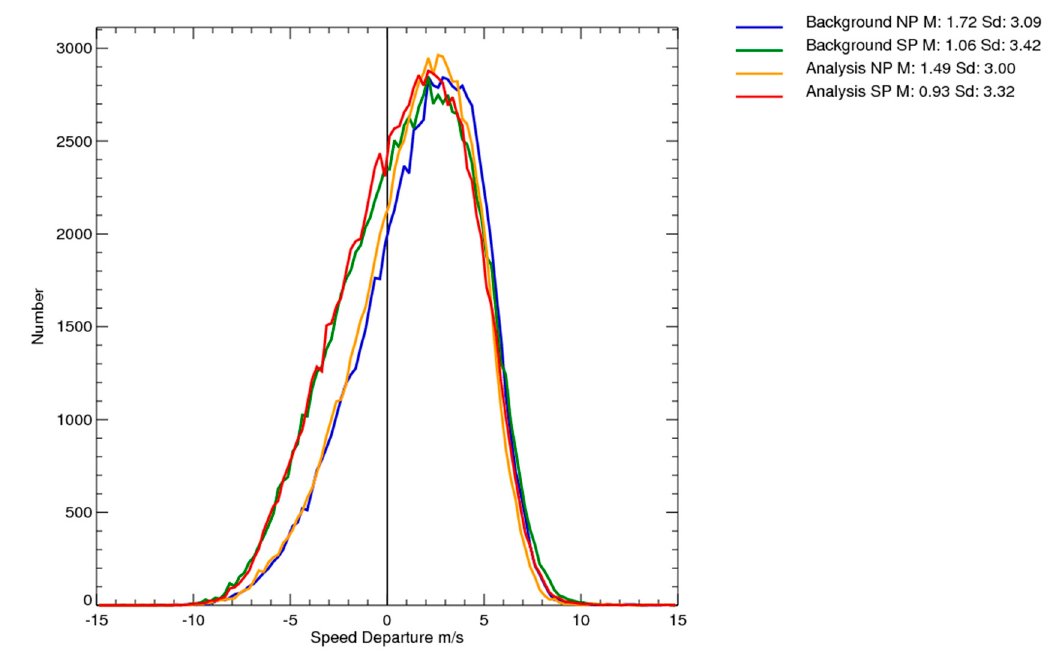
Figure 11. Distribution of speed departure for 01–29 July 2012 for the AIRS ozone AMVs. Compared to the background (Arctic–blue; Antarctic–green) and analysis (Arctic–yellow; Antarctic–red). The impact per observation (Figure 12) is very good for the AIRS moisture AMVs, as they are ranked higher than all other satellite-derived wind datasets. This indicates the winds are of good quality. However, the AIRS ozone AMVs have a negative impact, which is likely a result of the large speed bias.